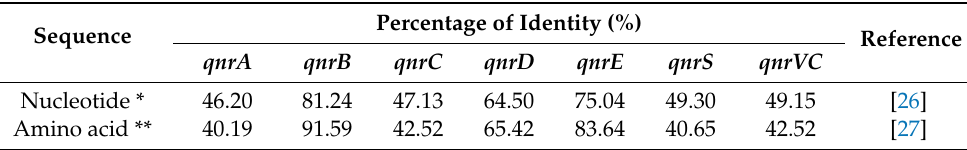
Table 2. Similarity of nucleotide and amino acid sequences of qnrB89 carried by Citrobacter gillenii FP75 with those of the alleles of the qnr